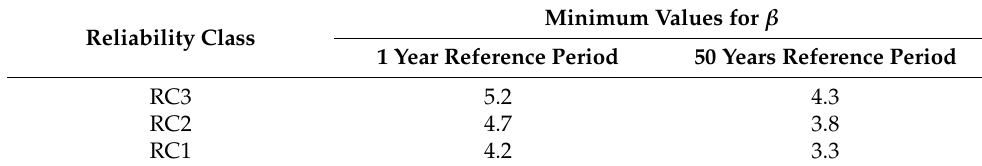
Table 4. Recommended minimum values for reliability index β .